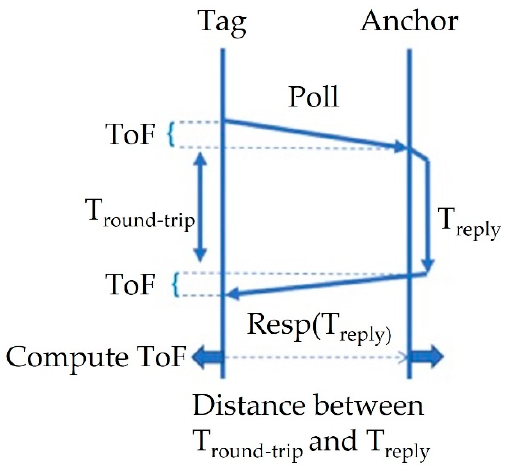
Figure 2. Block diagram of DWM1001-DEV/MDEK1001 module [35].